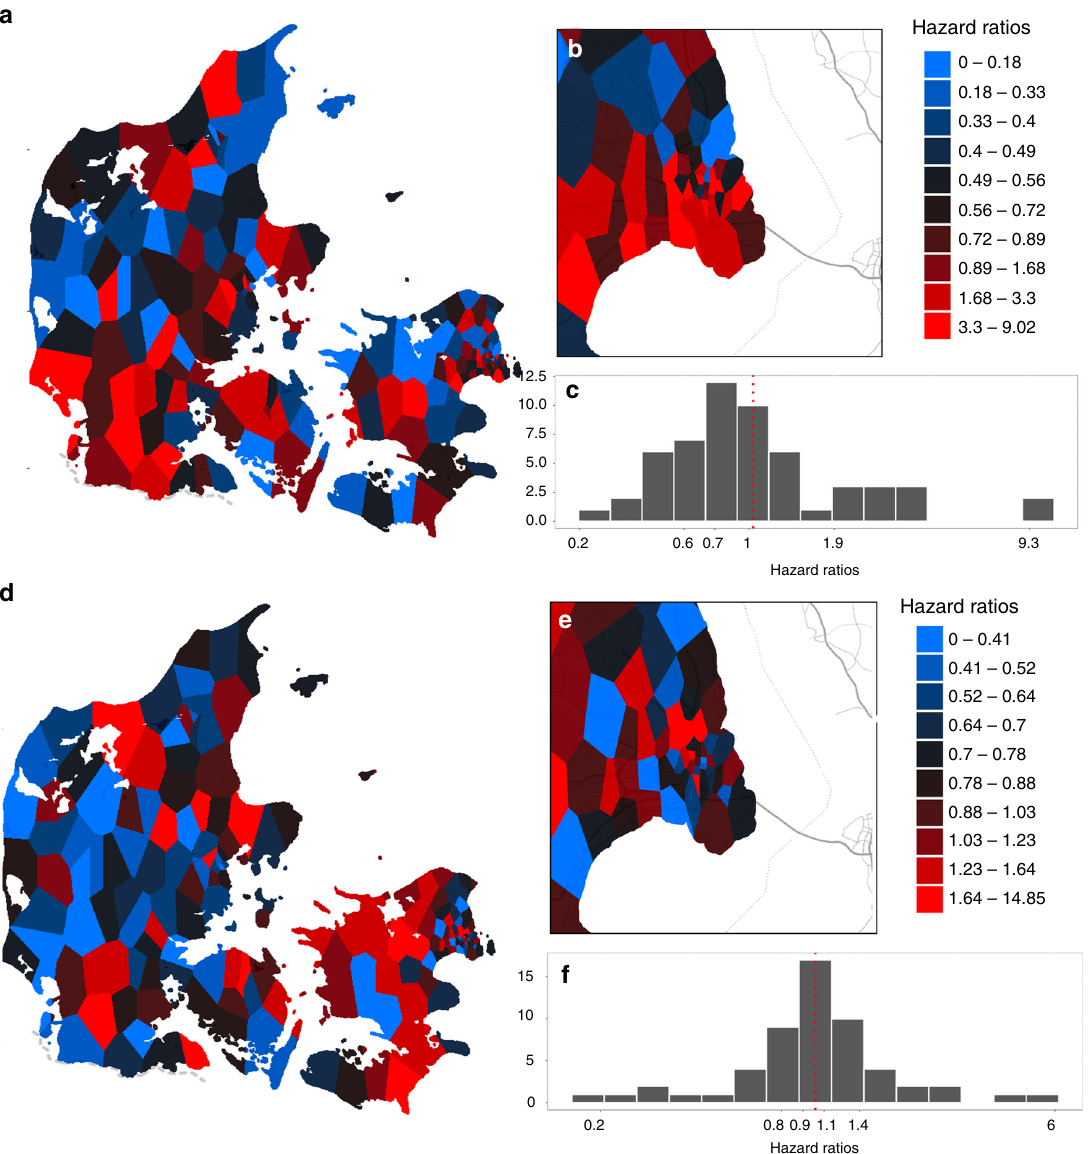
Fig. 2 Risk distribution of E and GxE. The estimated E component is shown in the upper panel ( a – c ) while the estimated GxE component is shown in the lower panel ( d – f ). All colors were centered on national average while scaled according to risk deciles. a Hazard ratios distribution of E component in Denmark. b Hazard ratios distribution of E component in the metropolitan area, Copenhagen. c Histograms of E risk distribution within the metropolitan area. d Hazard ratios distribution of GxE component in Denmark. e Hazard ratios distribution of GxE component in the metropolitan area, Copenhagen. f Histograms of GxE risk distribution within the metropolitan